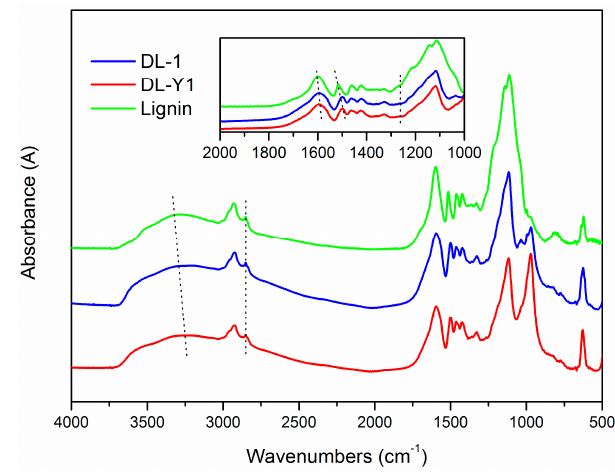
Figure 3. Fourier transform infrared (FT-IR) spectra of lignin, DL-1, and DL-Y1.